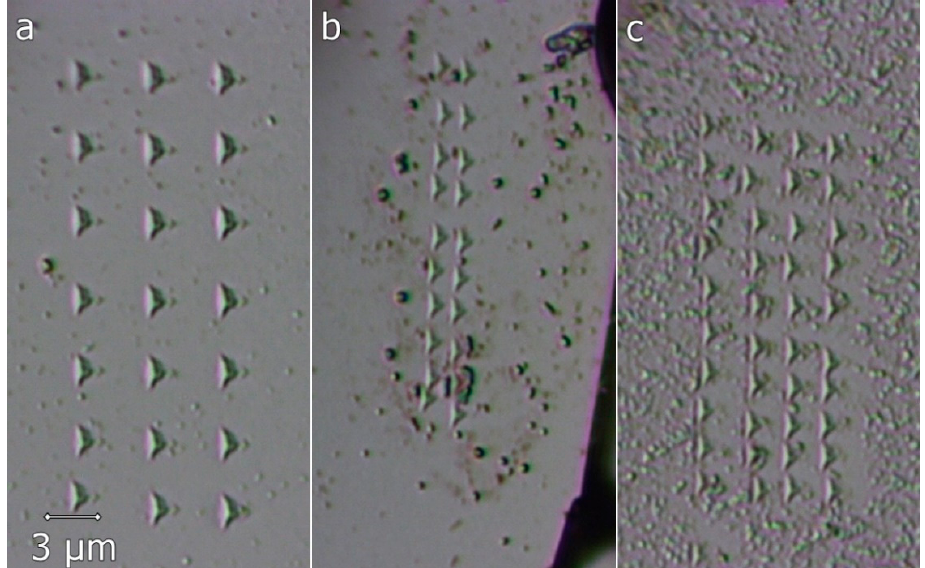
Figure 12. Instrumented indentation imprints on the thermally treated melt-spun ribbons: ( a ) Ti 60 Zr 10 Si 15 Nb 15 ribbon—MS2; ( b ) Ti 64 Zr 10 Si 15 Nb 11 ribbon—MS2; ( c ) Ti 56 Zr 10 Si 15 Nb 19 ribbon—MS2. Table 4. Mechanical properties of the Ti-based alloys, either in bulk form or in melt-spun ribbon form. Alloy